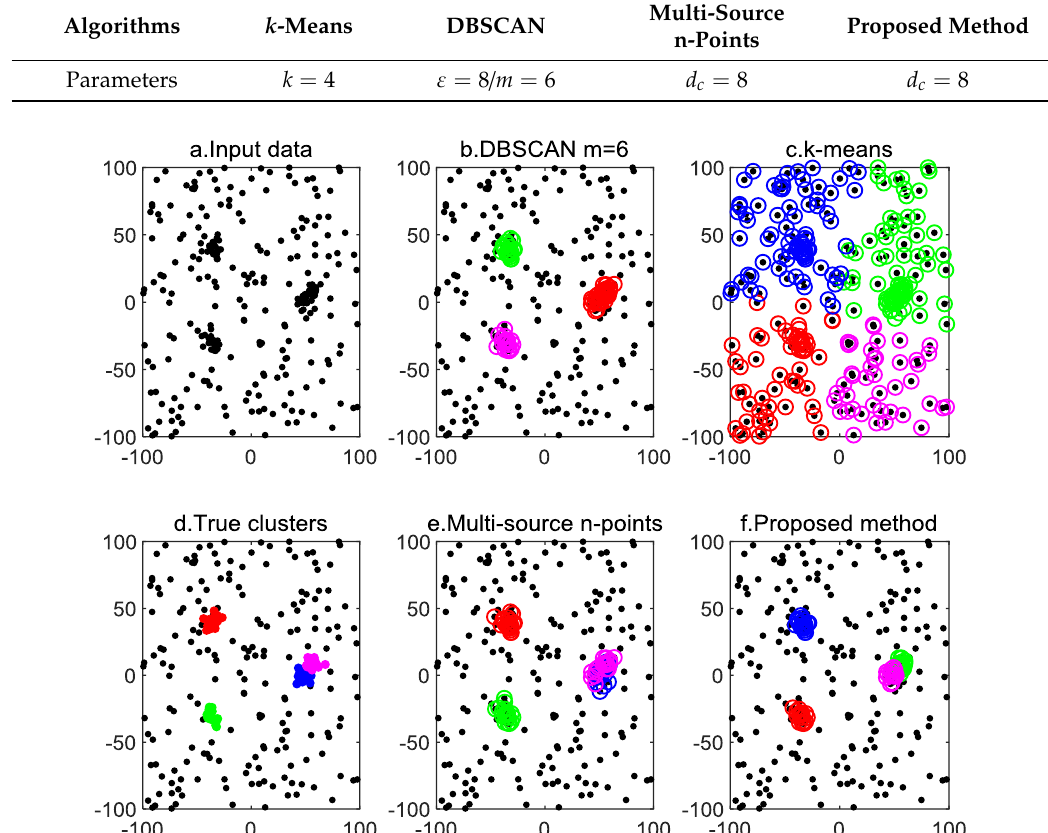
Figure 5. Outcomes of different clustering methods for data from 50 i.i.d.